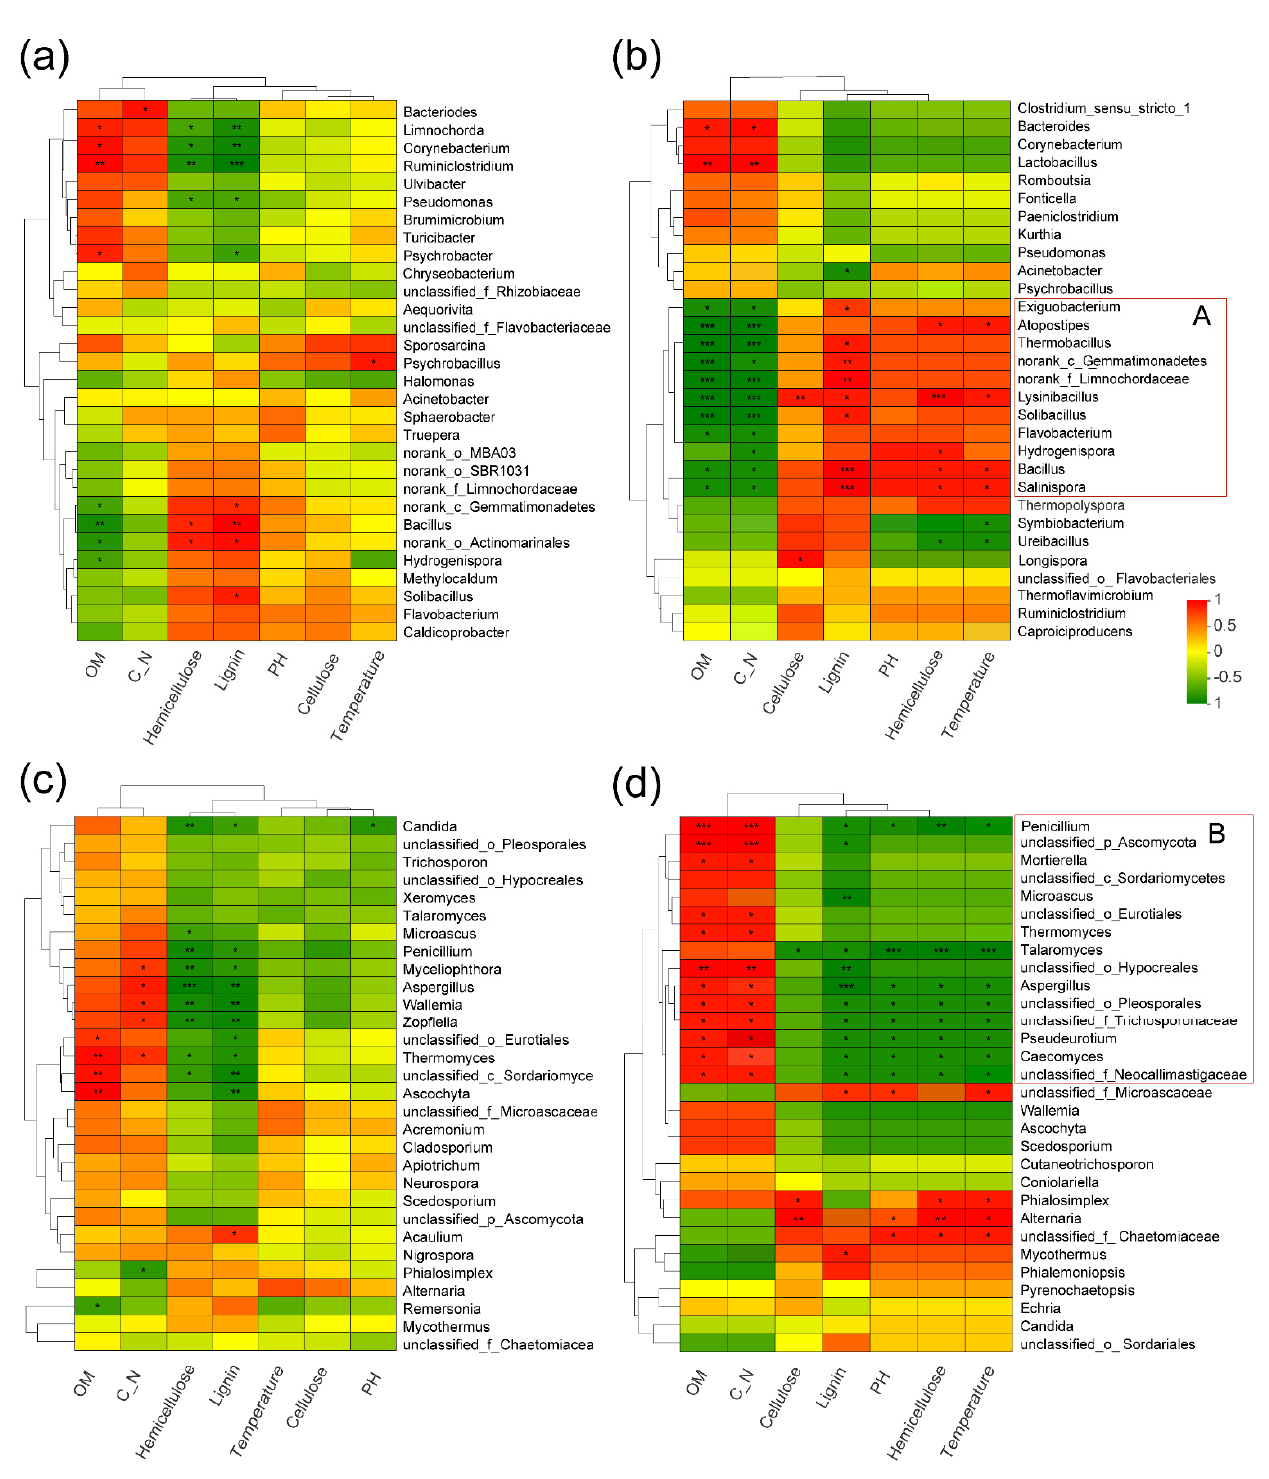
Figure 6. Heatmap showing relationship analysis of physicochemical parameters and the ( a ) bacterial genera in CK, ( b ) bacterial genera in LFPO, ( c ) fungal genera in CK and ( d ) fungal genera in LFPO. (* 0.01 < p ≤ 0.05, ** 0.001 < p ≤ 0.01, *** p ≤ 0.001). Red lines were the microbial cluster.